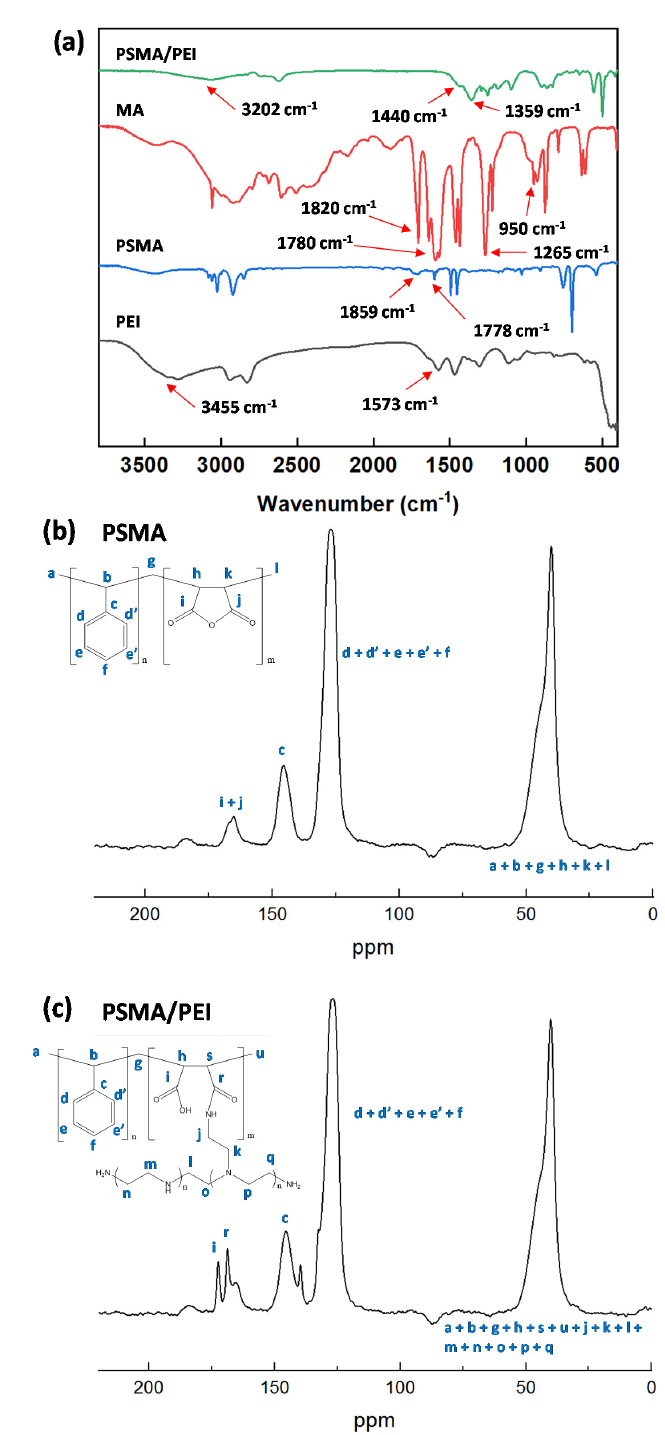
Figure 2. ( a ) FT-IR spectra of PSMA / PEI core–shell nanoparticles, PSMA, PEI, and MA; 13 C-NMR spectra (500 MHz) of ( b ) PSMA and ( c ) PSMA /